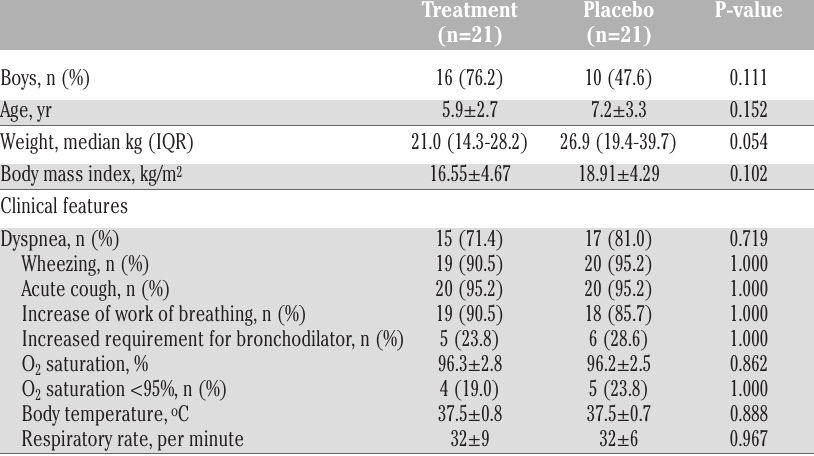
Table 1. Demographic and clinical characteristics (values are mean±standard